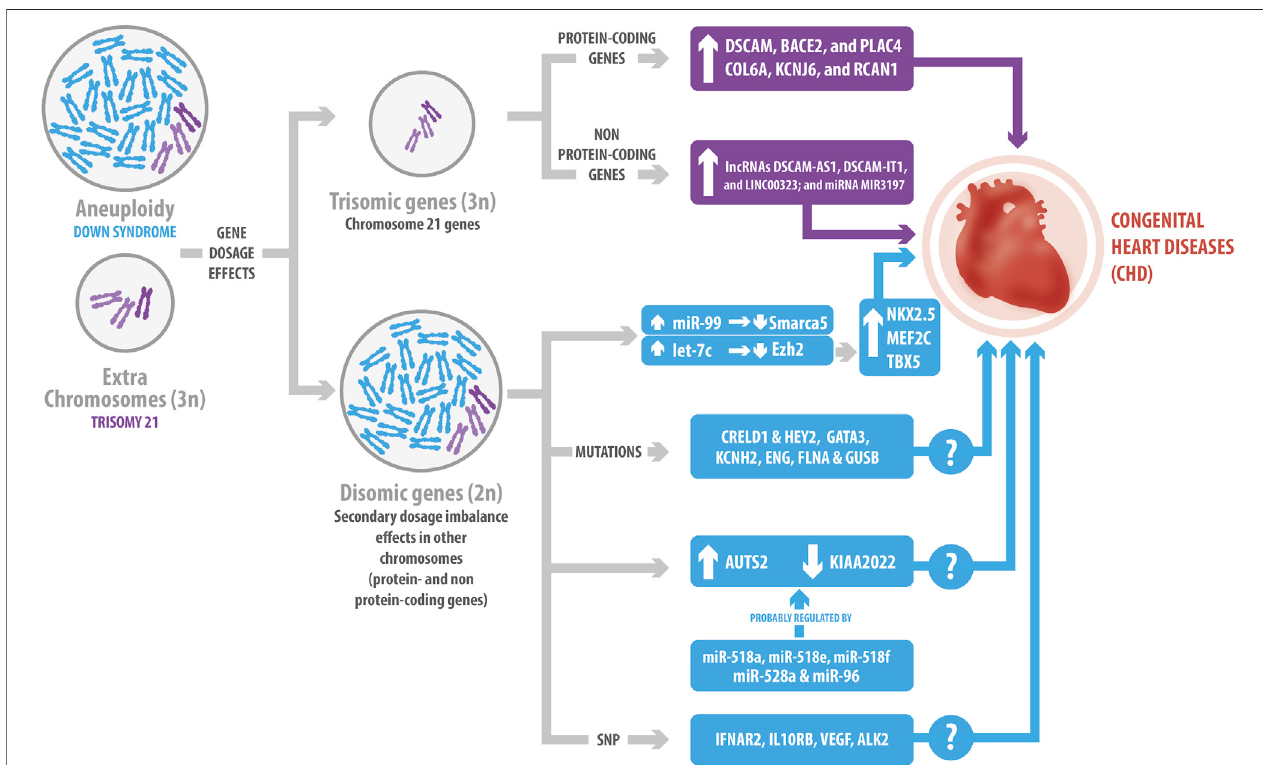
FIGURE 1 | Genetic in fl uence of Down Syndrome (DS) in congenital heart diseases (CHD). The gene dosage effects due to the overexpression of protein-coding and non-protein coding Hsa21genes have been related to CHD. Hsa21 protein-coding genes include DSCAM , BACE2 , PLAC4 , COL6A , KCNJ6 and RCAN1 . Hsa21 non-protein-coding genes include lncRNAs, such as DSCAM-AS1 , DSCAM-IT1 and LINC00323 ; and the MIR3197 miRNA. The extra chromosome in DS changes the genomiccontext,generatingasecondary dosageimbalance effectinotherchromosomes.Thisleadstovariationsintheexpressionlevelsofnon-Hsa21genes,as well as mutations; such is the case of the changes observed for CRELD1 , HEY2 , GATA3 , KCNH2 , ENG , FLNA and GUSB , which might cause CHD. Additionally, the miR-99/let-7c cluster interacts with EZH2 and SMARCA5, regulating the expression of some transcriptional factors involved in cardiogenesis. Several miRNAs might have also a role in the development of CHD, such as miR-518a, miR-518e, miR-518f, miR-528a, and miR-96, which potentially co-regulate AUST2 and KIAA2022 . Finally, single nucleotide polymorphism has been associated with CHD, like the ones described for IFNAR2 , IL10RB , VEGF and ALK2. However, several of the mechanisms underlying these effects still remain